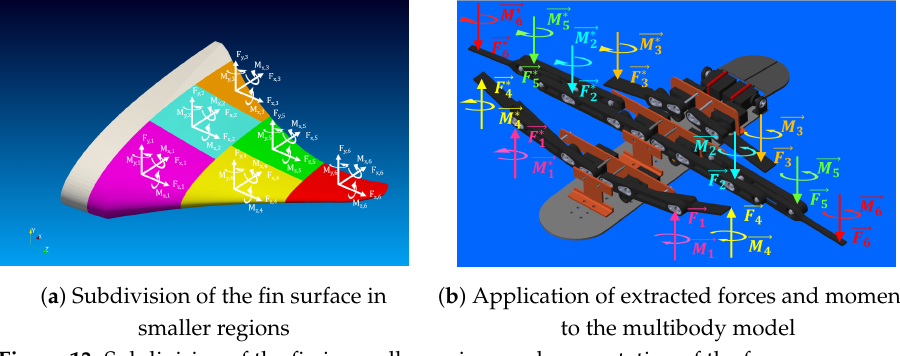
Figure 13. Subdivision of the fin in smaller regions and computation of the forces.